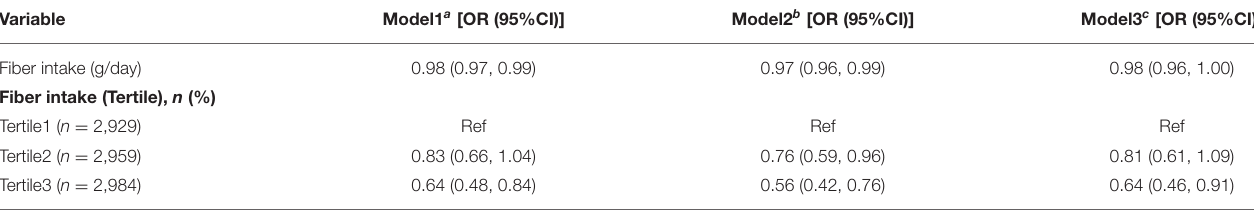
TABLE 3 | Results of the multivariate logistic regression analysis of association between fiber intake and nonfatal cardiovascular/cerebrovascular events, weighted. Variable